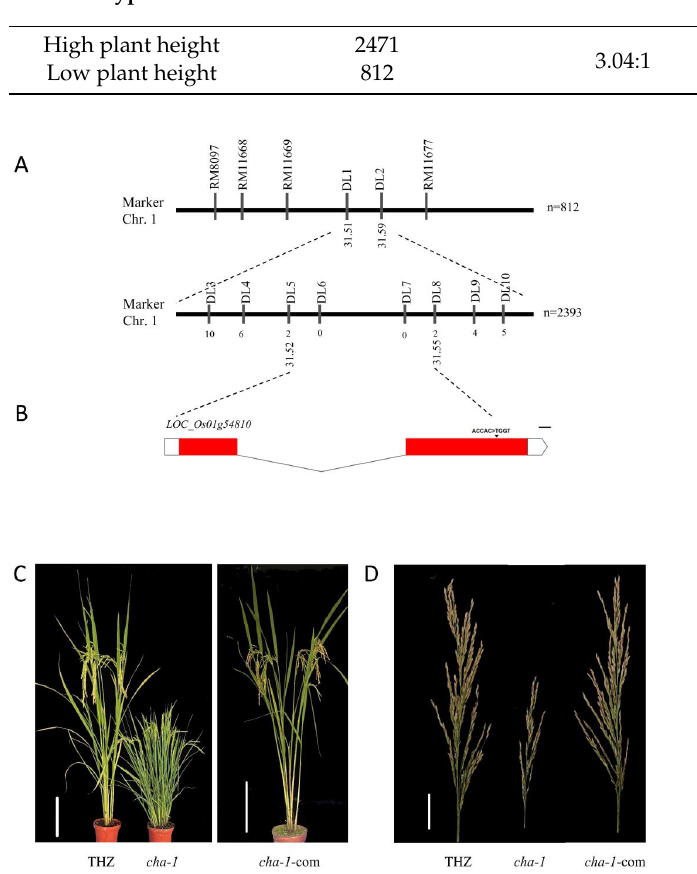
Figure 3. Fine mapping of CHA-1 . ( A ) CHA-1 was localized between markers DL10 and DL30 on chromosome 1. The name of the molecular markers are above the line, and the number below the line indicates the number of recombinants between CHA-1 and the molecular markers shown. ( B ) Gene structure and mutation site of the candidate gene LOC_Os01g54810 . ( C ) Morphology of THZ, CHA-1 , and CHA-1-com at the mature stage. Scale bar, 20 cm. ( D ) Panicle morphology of THZ, CHA-1 , and CHA-1-com . Scale bar, 10 cm. CHA-1-com is a complementary plant based on CHA-1 .